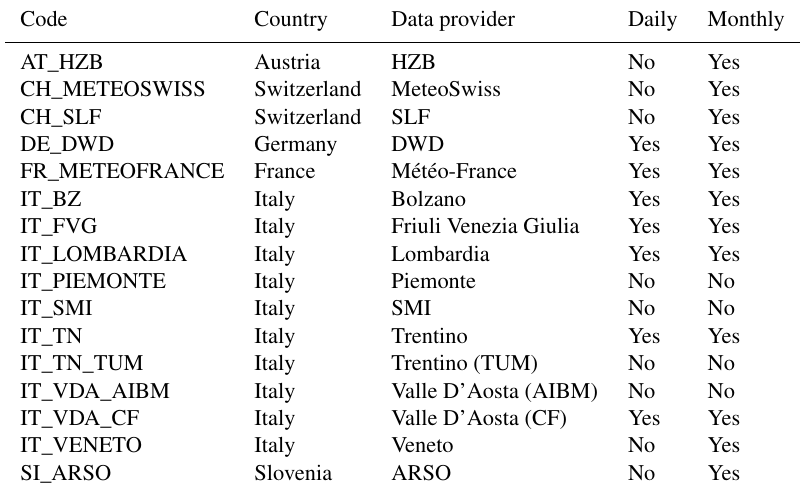
Table B3. Overview of shareable data. The column “daily” indicates if the original daily data can be shared and “monthly” if the derived monthly data can be